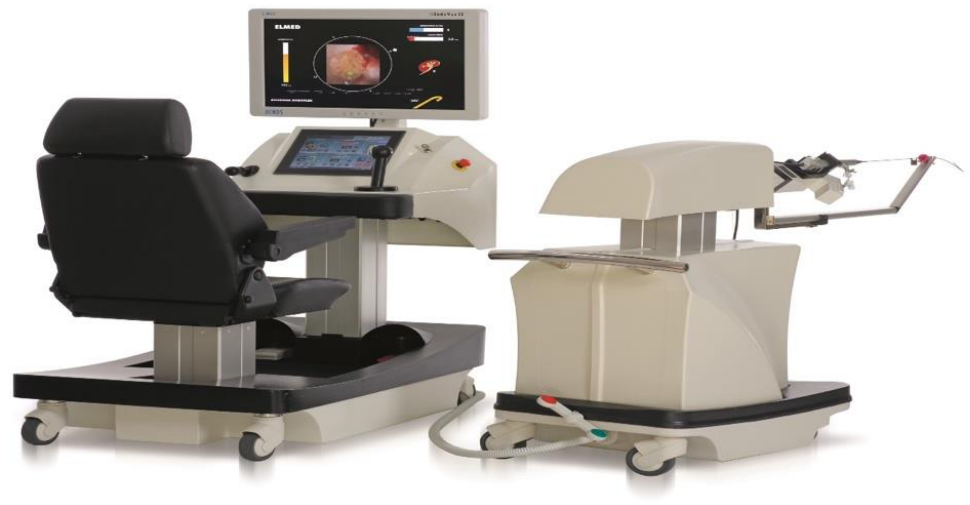
Figure 1. Roboflex Avicenna: console with chair and manipulator for scope. The console allows for a surgeon to be seated and control the manipulator via two joysticks that allow up and down deflection and side-to-side manipulation. The control monitor with its touch screen access manipulates the advancement and retraction of the laser fiber and adjustment of the irrigation flow rate. In addition, the degree of rotation and deflection is displayed. Two foot pedals are integrated to control the laser device and fluoroscopy. The manipulator consists of the motor system and the robotic arm, which holds and moves the endoscope at an adjustable height to match the patient’s